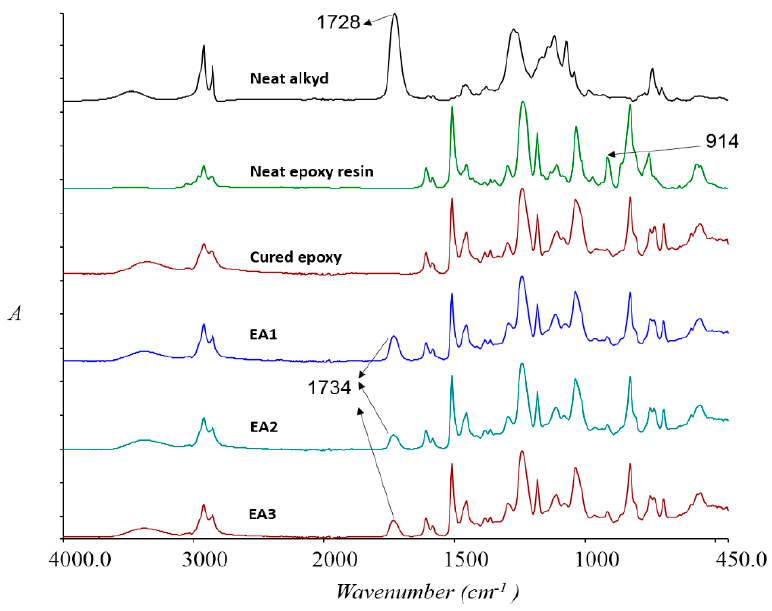
Figure 16. FTIR spectra of neat alkyd, epoxy resin and cured epoxy, EA1, EA2 and EA3 samples.